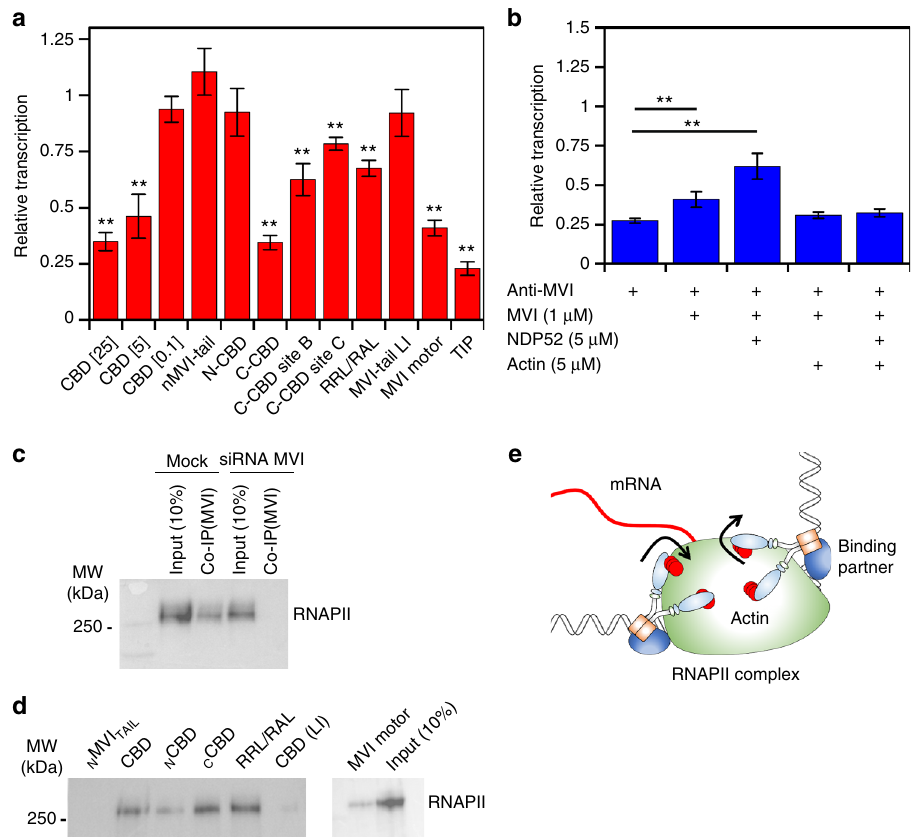
Fig. 7 Coupling myosin VI to the RNAPII complex. a In vitro transcription by HelaScribe extracts in the presence of competitor MVI domains at 25 μ M, unless stated otherwise. Sites B and C refer to C CBD Δ SiteB and C CBD Δ SiteC , respectively. TIP refers to the control reaction performed in the presence of 25 μ M of the MVI inhibitor (TIP). Samples were normalised to the control sample in Fig. 6f (error bars represent SEM from fi ve independent experiments ** p < 0.001 by two-tailed t -test). See Supplementary Fig. 8c for control experiments. b In vitro transcription following antibody depletion and rescue